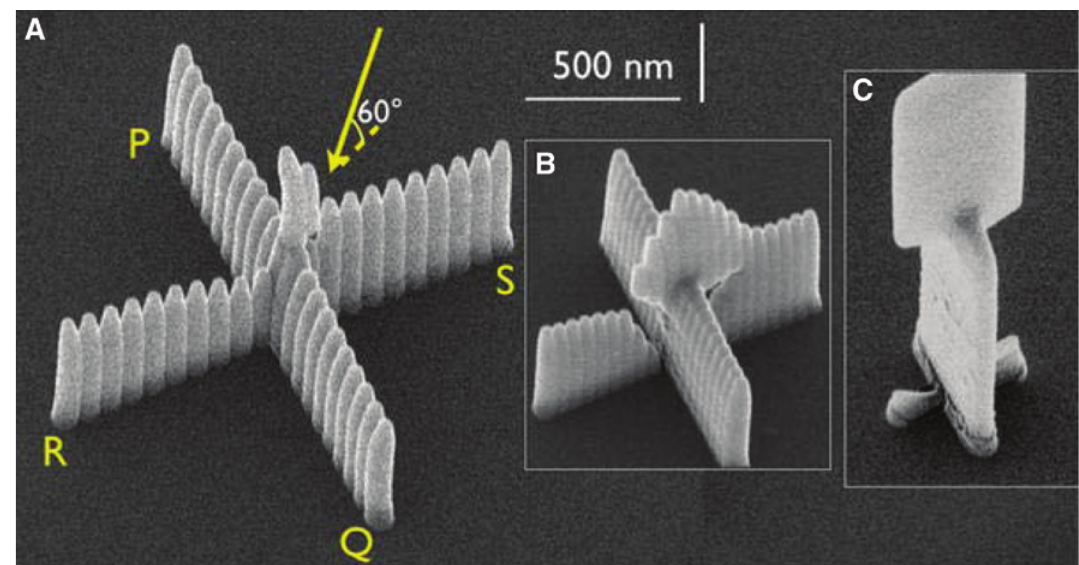
Figure 12: 3D deposition by He-IBID (110): crosses formed by two successively He-ion IBID grown rows of pillars with 75 nm (A), 50 nm (B), and 20 nm (C)